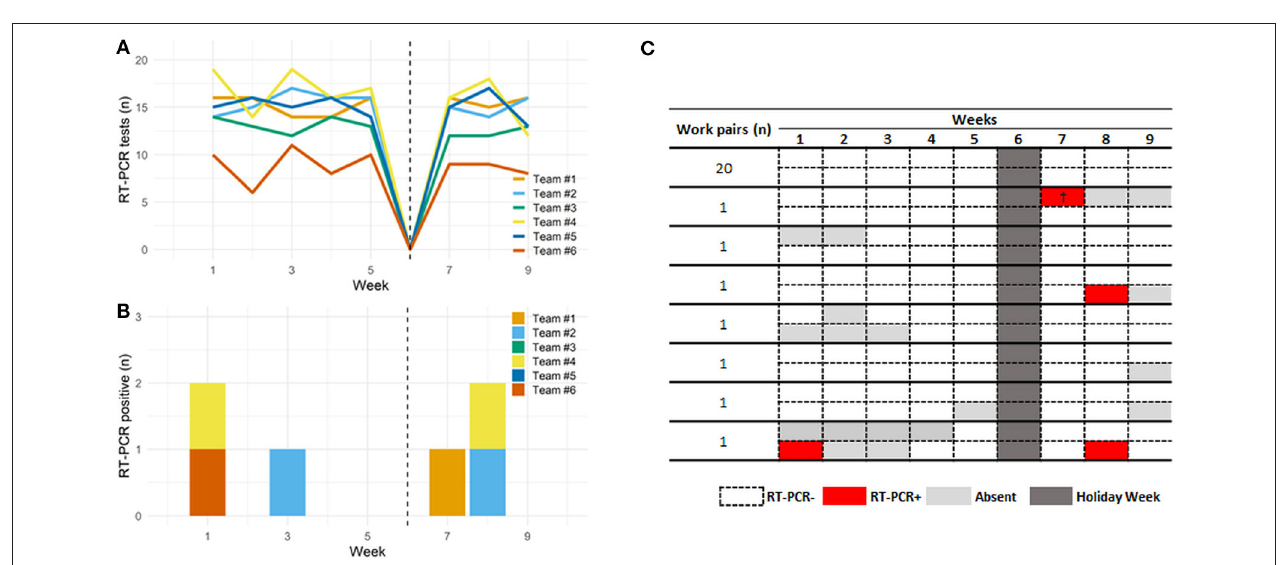
FIGURE 3 | RT-PCR tests and results for SARS-CoV-2 in dental healthcare professionals. (A) Shows the number of RT-PCR tests during study timeline per team composed by teachers, dental students and dental assistants. The number varied between teams due to the absence of some participants, either because of COVID-19 diagnostic or personal reasons. (B) Shows the number of RT-PCR positive cases by team during the 9 weeks. (C) Shows the presence and results found in work pairs of dental students. (†), shows the sequenced samples of the SARS-CoV-2 zeta variant.